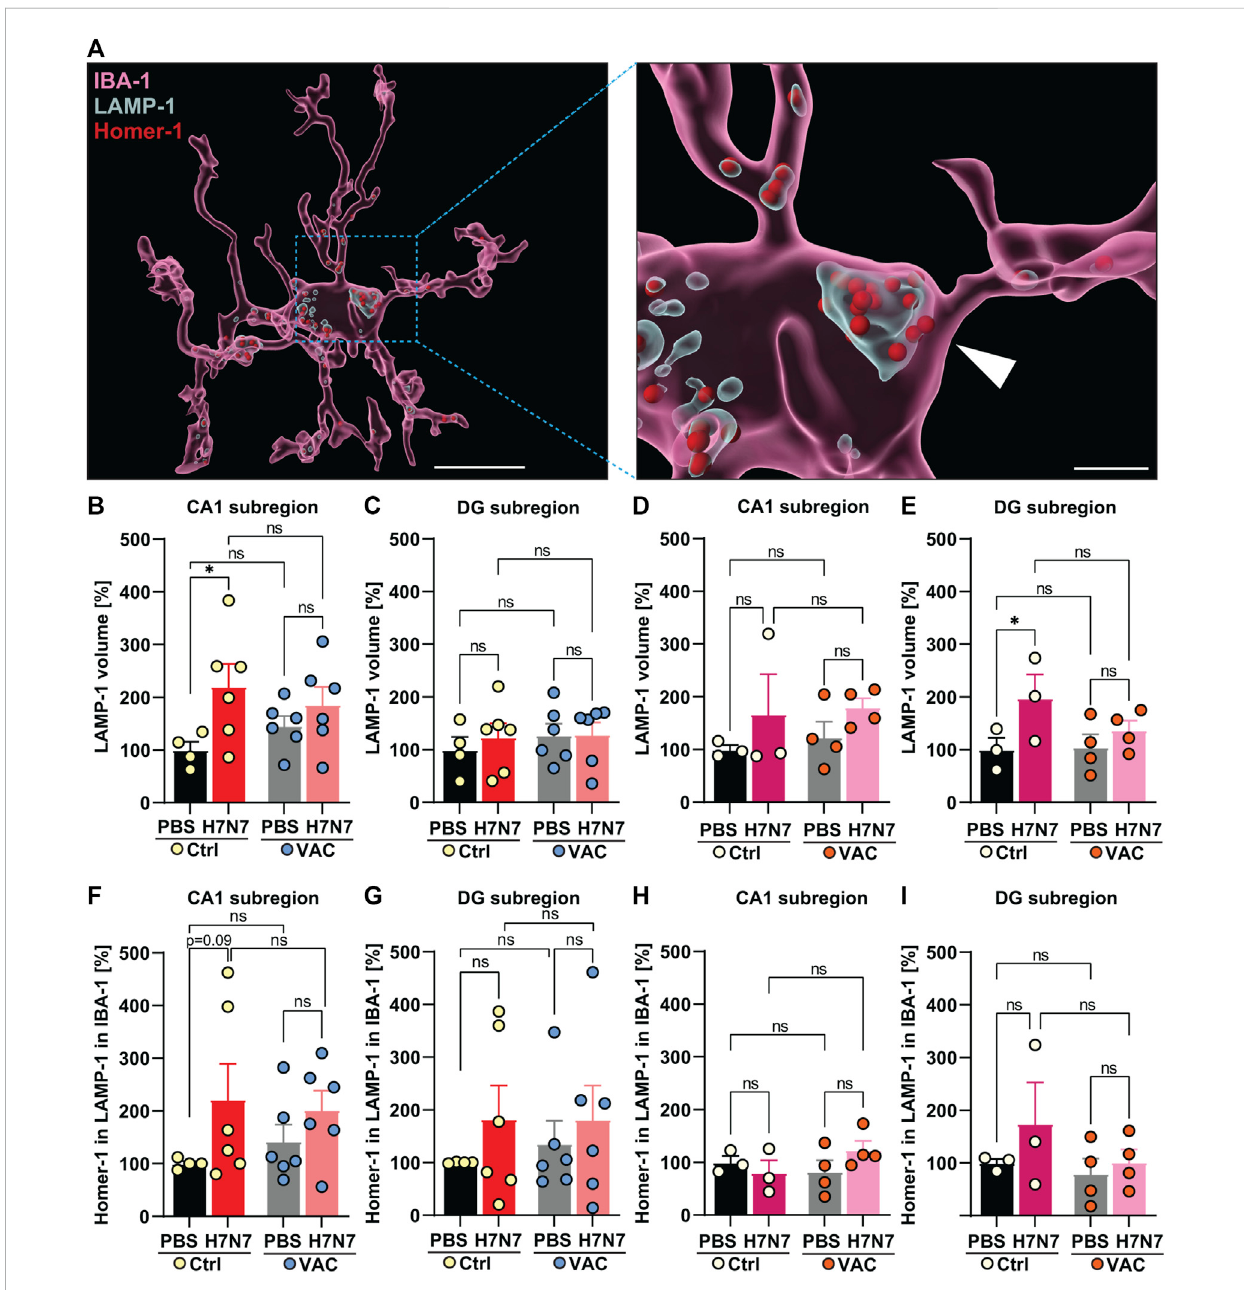
FIGURE 7 Synaptic engulfment by microglia induced by H7N7 IAV infection and its possible modulation by vaccination. (A) Representative reconstruction of a microglialcell,alysosomalcompartment,andHomer-1positivepostsynapticterminalsfromthe dentategyrus hippocampalsubregionofagedmice.The entire microglial cell is shown on the left image (Scale = 10 µm), while an enlarged section is shown on the right side. IBA-1 surface was remodeled in IMARIS, as well as LAMP-1 volume inside the IBA-1 and Homer-1 puncta, which were localized inside the LAMP-1 volume inside the IBA-1 surface (Scale = 2 µm). In young mice (B) , theLAMP-1 labeled lysosome volume in the microglial cells in theCA1 subregion of thehippocampus was signi fi cantly increased 8 days after infection with the H7N7 IAV in unvaccinated mice compared to the corresponding control group. This increase was less pronounced in vaccinated mice. In the CA1 subregion, vaccination itself did not cause signi fi cant changes in lysosome volume within the microglial cells of either PBS-inoculated group. (C) No signi fi cant changes were observed in the dentate gyrus of young mice after H7N7-IAV challenge, either between unvaccinated mice or between vaccinated mice. Vaccination per se did not also cause signi fi cant differences in this subregion ( n = 4 – 6 animals per group). In aged mice, (D) in the CA1 subregion, infection resulted in increased amounts of lysosome volume regardless of whether the mice had been previously vaccinated, although the difference was not statistically signi fi cant. (E) In the DG subregion, the volume of lysosomes in microglial cells increasedinunvaccinatedinfectedmice,whichwasnotveryevidentinvaccinatedmice.Thevaccinationitselfdidnotleadtoanysigni fi cantchanges( n